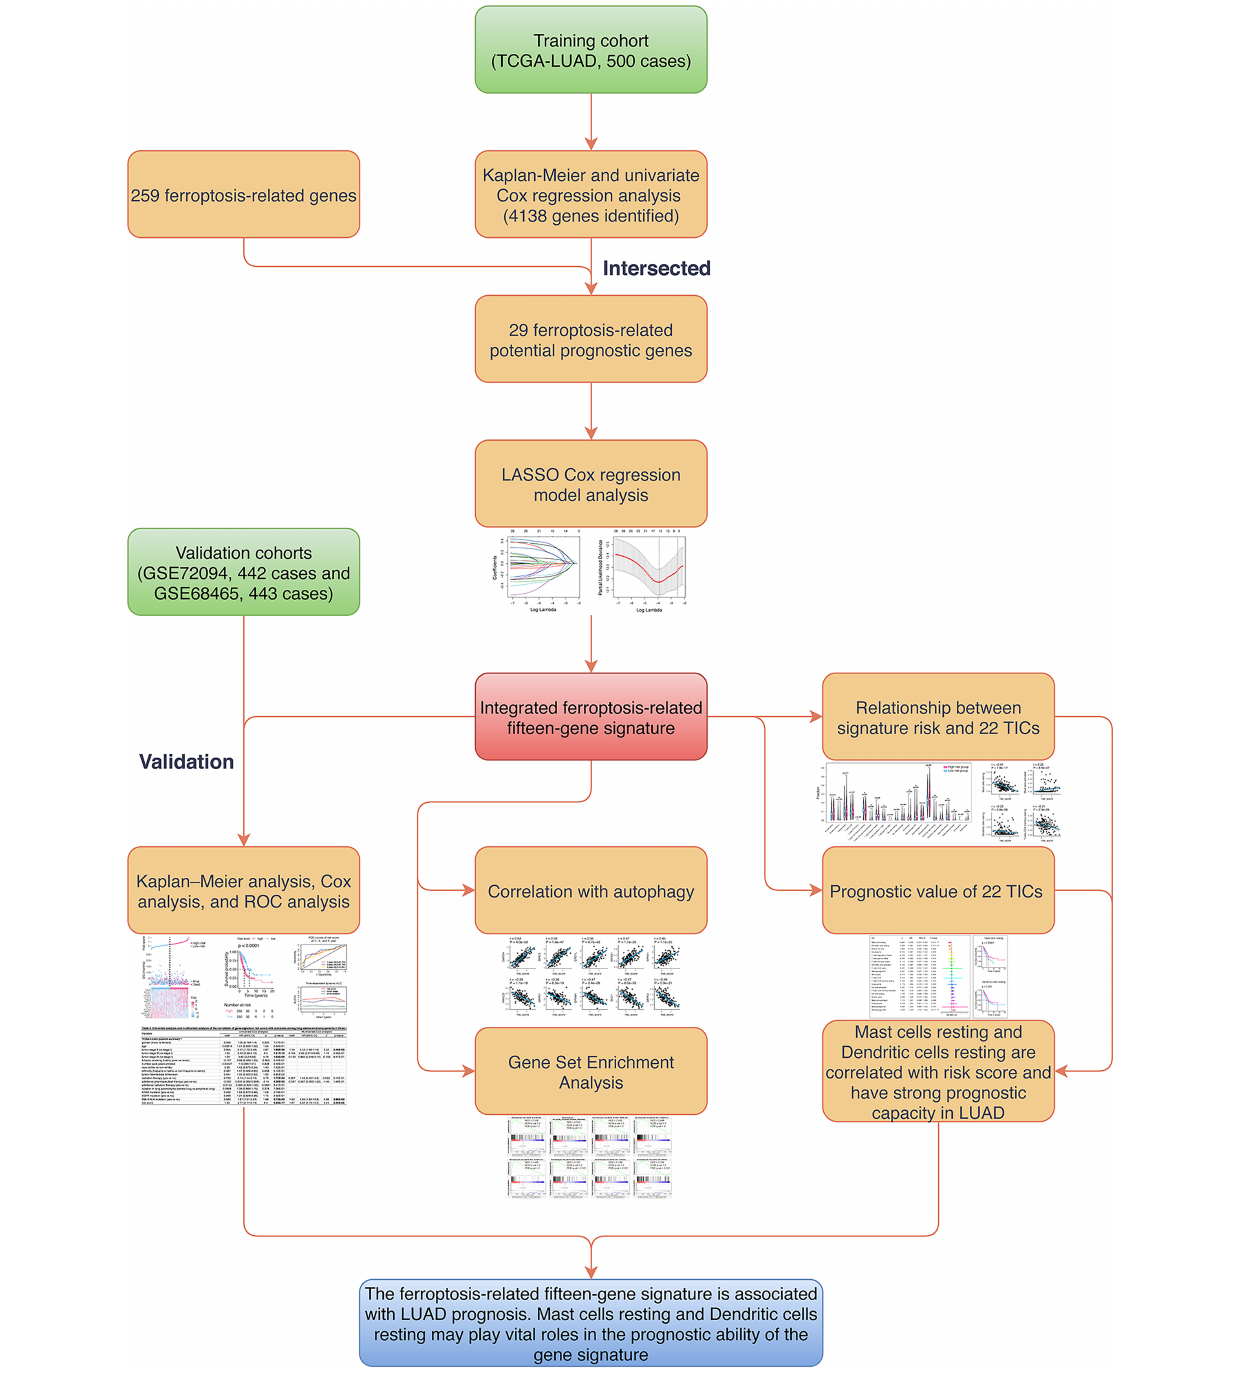
Frontiers in Cell and Developmental Biology |